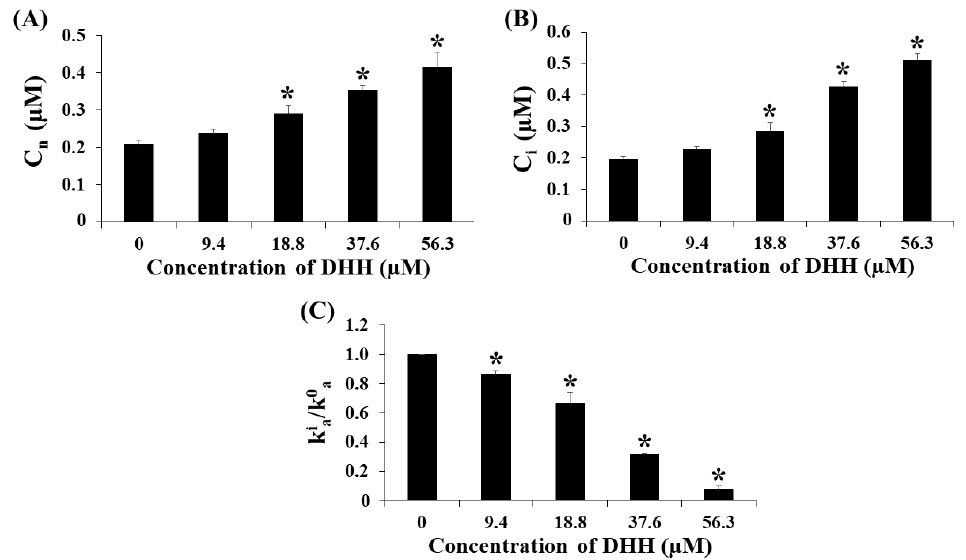
Figure 7. Effect of DHH on the pirarubicin (THP) accumulation in K562/ADR cells. a, vehicle control; b, 9.4 µM; c, 18.8 µM; d, 37.6 µM; and e, 56.4 µM.